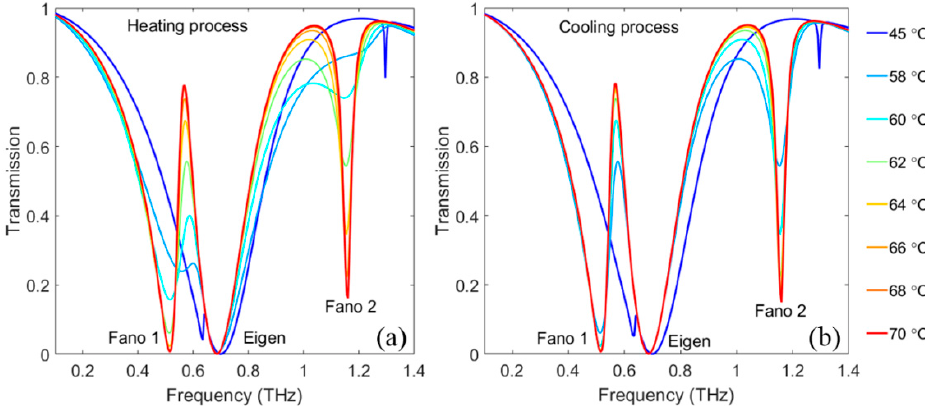
Figure 3. Simulated THz transmission spectra of the proposed VO 2 -implanted MM structure corresponding to different temperatures ， showing the active modulation of the two Fano resonances at 0.515 THz (Fano 1) and 1.160 THz (Fano 2): ( a ) heating process; ( b ) cooling process.